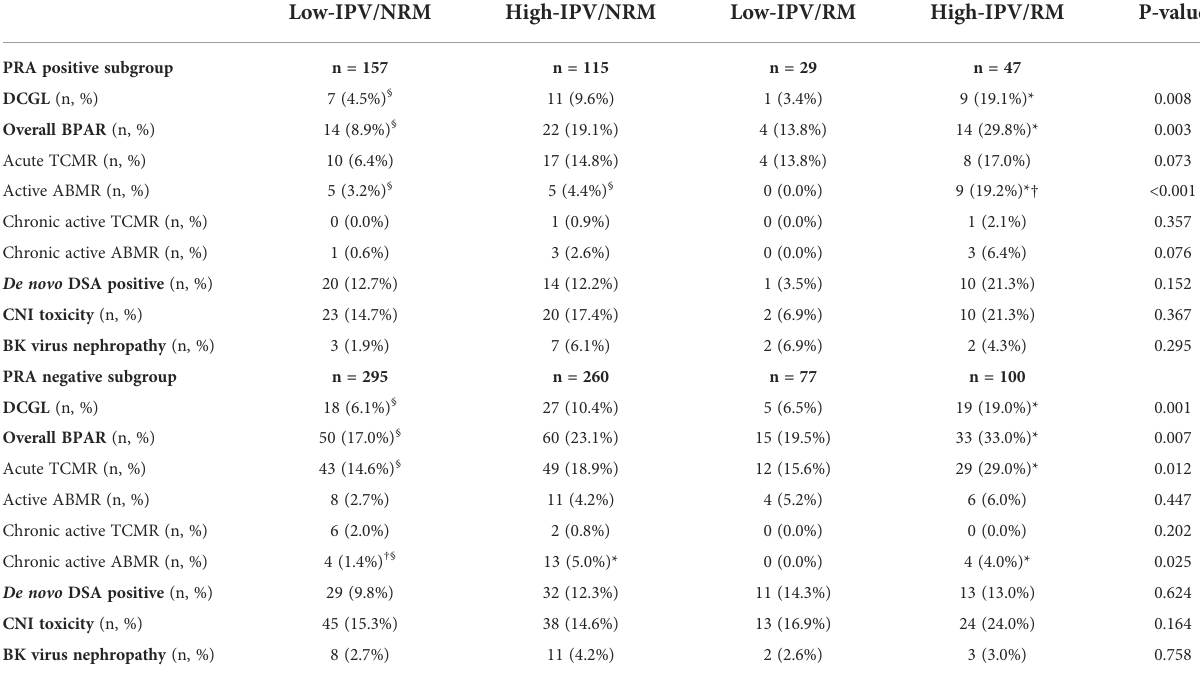
TABLE 4 Incidences of BPAR and other outcomes according to TAC-IPV and RM/NRM status in each PRA positive and negative